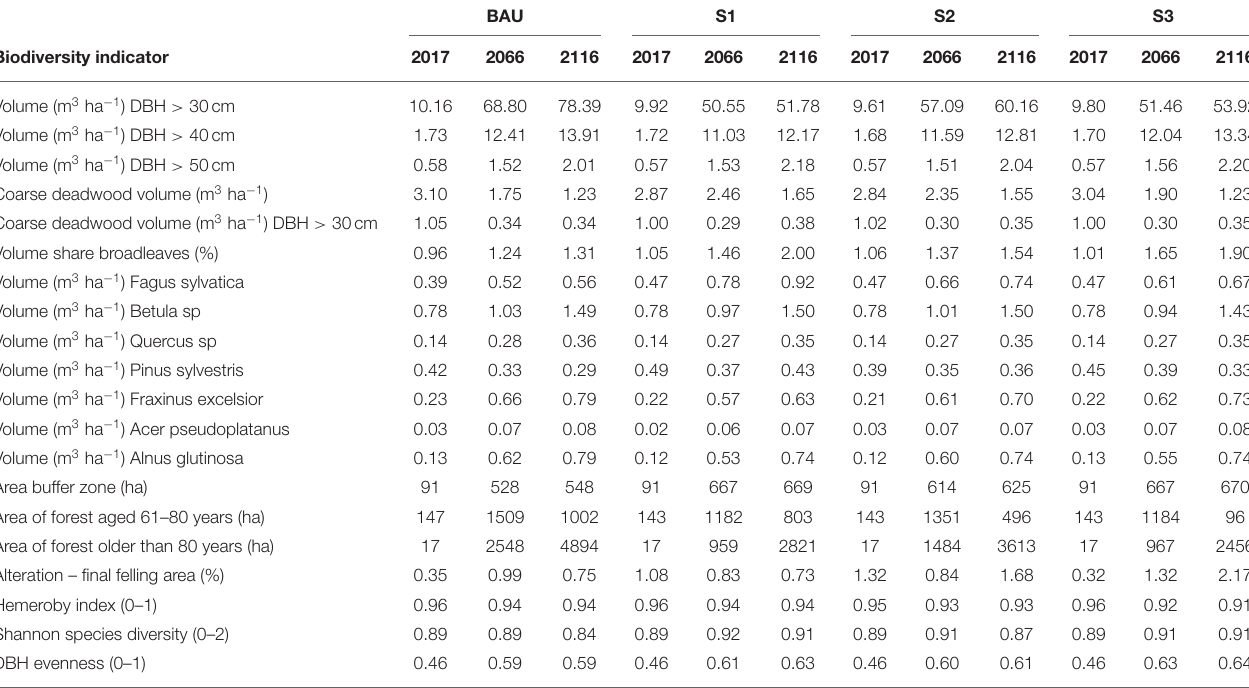
TABLE 2 | Biodiversity indicators for the four scenarios, BAU, S1, S2, and S3, at three time points: 2017, 2066, and 2116. BAU S1 S2 S3 Biodiversity indicator